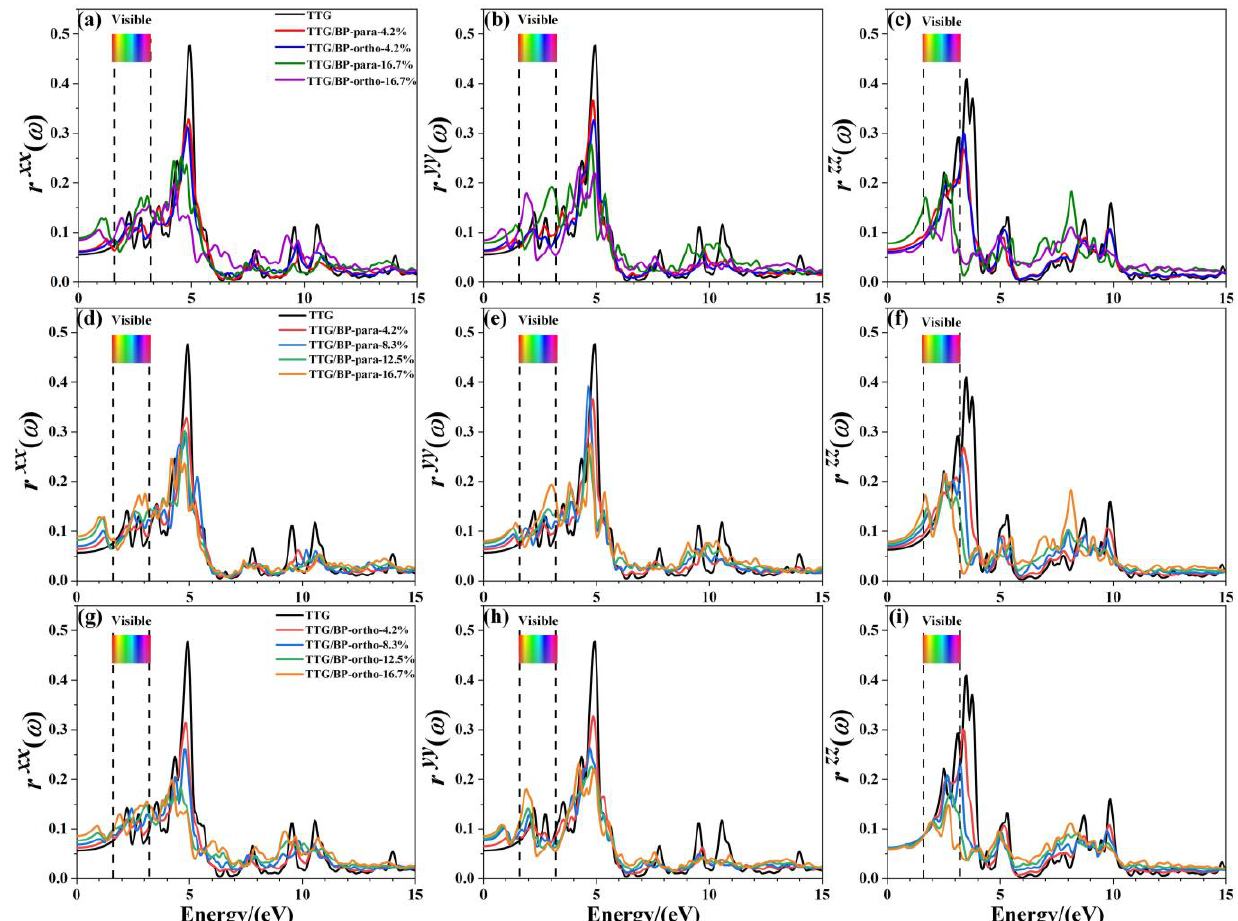
Figure 9. Reflectance of the TTG/BP systems. ( a ) 𝑟 𝑥𝑥 of TTG/BP; ( b ) 𝑟 𝑦𝑦 of TTG/BP; ( c ) 𝑟 𝑧𝑧 of ( d ) r xx of TTG/BP-para; ( e ) r yy of TTG/BP-para; ( f ) r zz of TTG/BP- para; ( g ) r xx of TTG/BP-ortho; TTG/BP; ( d ) 𝑟 𝑥𝑥 of TTG/BP-para; ( e ) 𝑟 𝑦𝑦 of TTG/BP-para; ( f ) 𝑟 𝑧𝑧 of TTG/BP- para; ( g ) 𝑟 𝑥𝑥 of ( h ) r yy of TTG/BP-ortho; ( i ) r zz of TTG/BP-ortho; ( h ) 𝑟 𝑦𝑦 of TTG/BP-ortho; ( i ) 𝑟 𝑧𝑧 of TTG/BP-ortho.